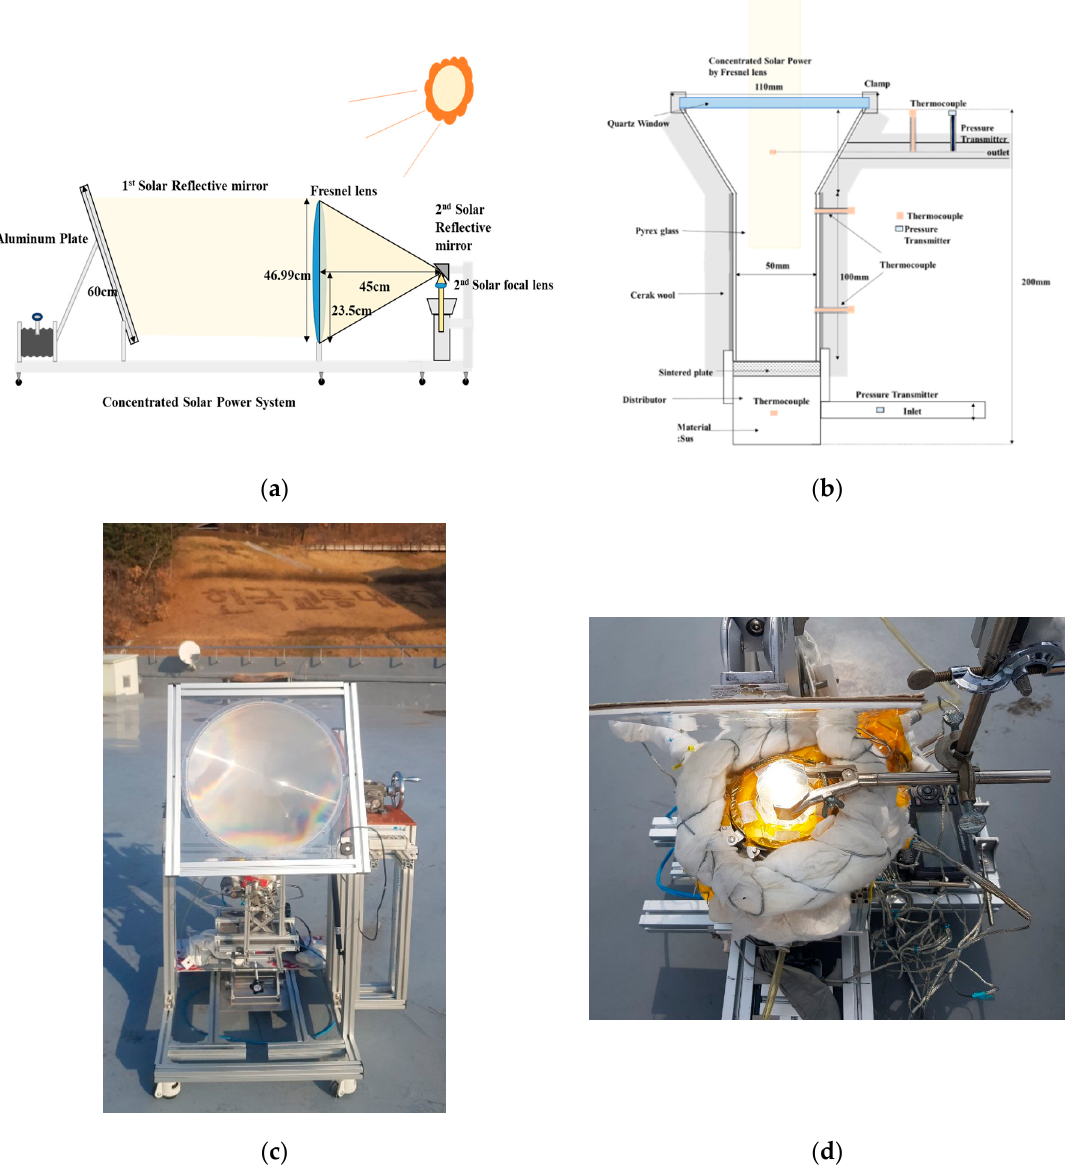
Figure 1. Experimental apparatus of solar heat gas heater system: ( a ) solar light collector, ( b ) particle receiver, ( c ) photo of the system in the field test, ( d ) top view of the particle receiver in the field test.